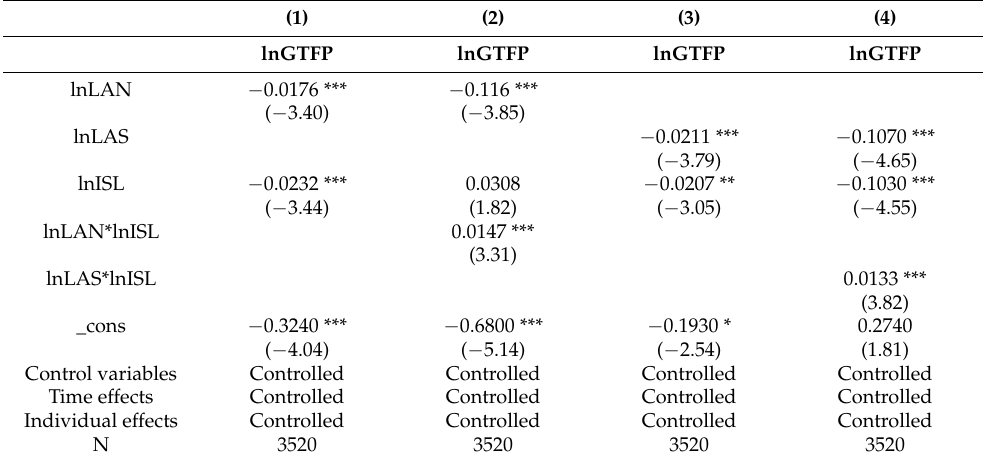
Table 10. Impact of infrastructure investment levels on land market: results of regulatory effects.